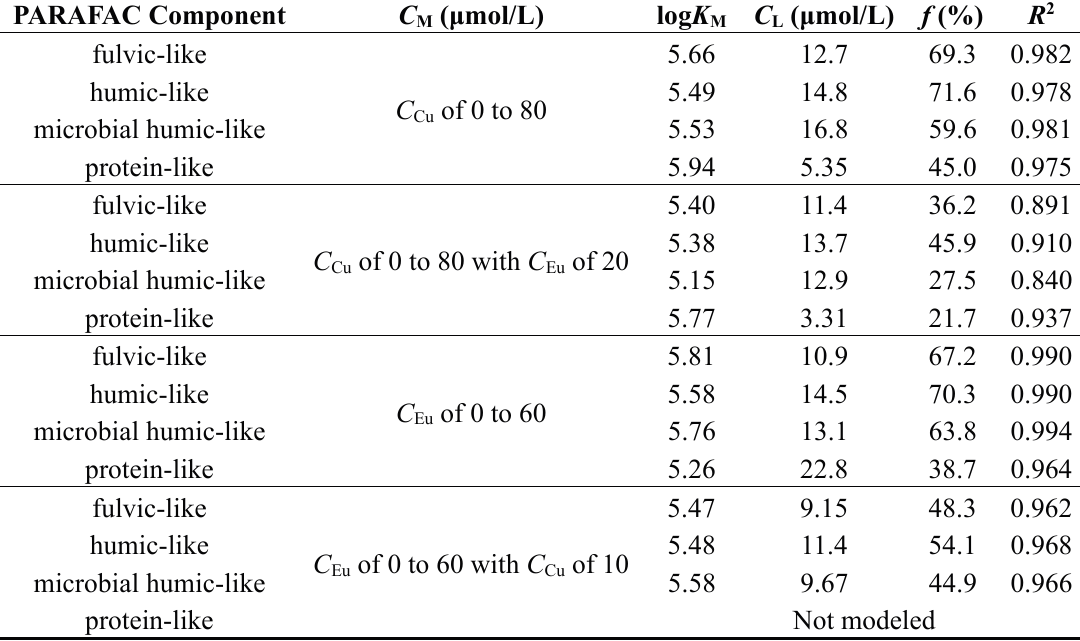
Table 1. Conditional binding parameters of PARAFAC-derived components with Cu(II) and Eu(III) determined by modified Ryan and Weber